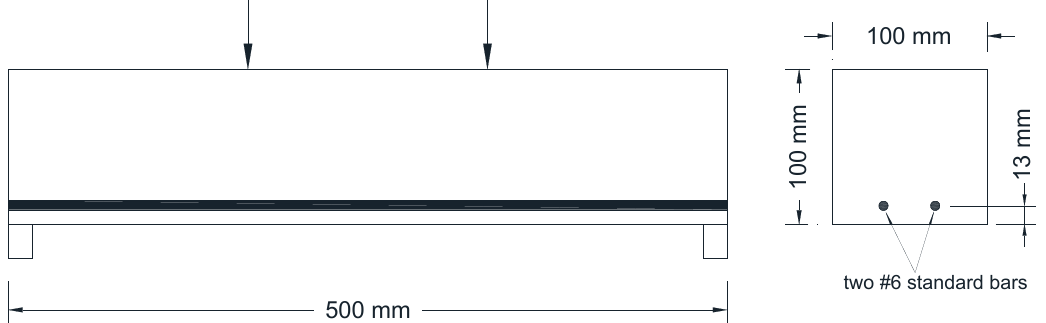
Figure 3. Schematic of the four-point bending test setup and beam reinforcement.